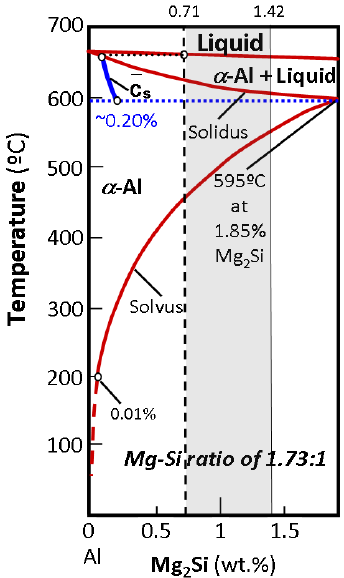
Figure 2. Pseudo-binary Al-Mg Si phase diagram for a Mg:Si weight ratio of 1.73:1. 2 The displacement of the average composition of the solid under nonequilibrium conditions corresponding to industrial solidification practices is